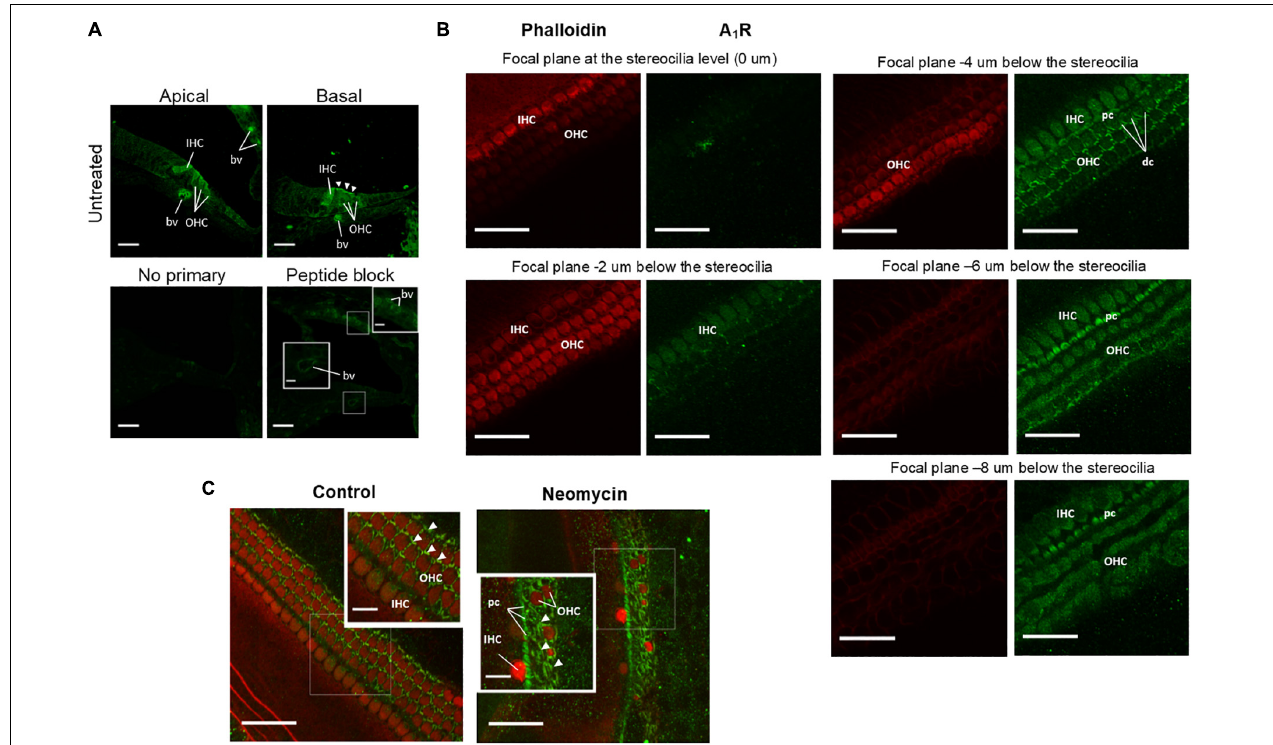
FIGURE 6 | Adenosine A 1 receptor immunolabeling of the developing mouse organ of Corti explants. (A) Cross sections of the P3 mouse cochlea (apical and basal turns) labeled with A 1 R-specific antibody. A 1 R are immunoexpressed in both inner (IHC) and outer (OHC) hair cells. Strong immunolabeling was present in the cuticular plate region of the OHC in the basal turn (arrowheads). Blood vessels (bv) in the basilar membrane were also immunolabeled, but similar labeling was also observed in peptide block controls. The primary antibody was omitted or pre-incubated with the corresponding peptide in control sections. (B) Whole mounts of the mouse organ of Corti at P3 showing A 1 R immunoexpression at descending focal planes (2 µ m optical sections) starting from the stereocilia level. Images were taken from the middle turn of a control cochlea and double labeled for adenosine A 1 R (green) and phalloidin (red). As expected, phalloidin labeling was restricted to the stereocilia and the cuticular plates of the hair cells. A 1 R immunolabeling was observed in Deiters’ cell (dc) phalangeal processes, cell bodies of IHC, OHC and the pillar cells (pc). (C) Whole mounts of the P3 mouse cochlea showing A 1 R immunoexpression (green fluorescence, arrowheads) in the middle segment of the control and neomycin-treated tissues. Neomycin-treated cochlea demonstrates substantial loss of sensory hair cells in the middle turn and enhanced A 1 immunofluorescence in the supporting (scar) cells (arrowheads). Scale bars: main, 30 µ m; inset, 10 µ